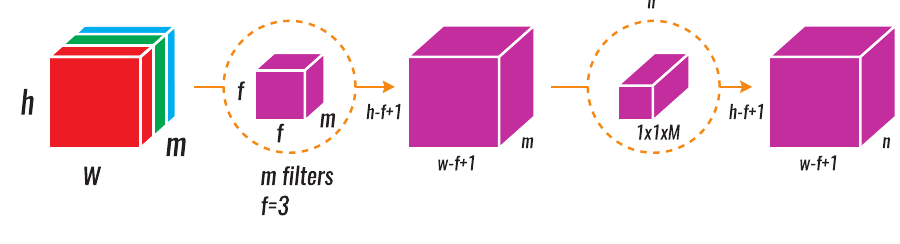
Figure 6. Graphic description of Depthwise Separable